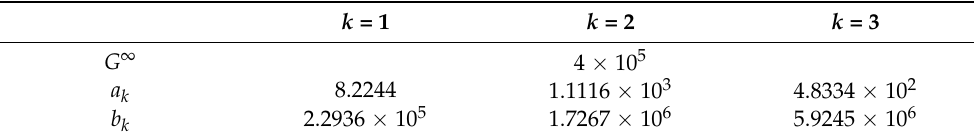
Table 5. Fitted parameters of the Biotmodel for EAR-C1002 at 23.9 ◦ C.